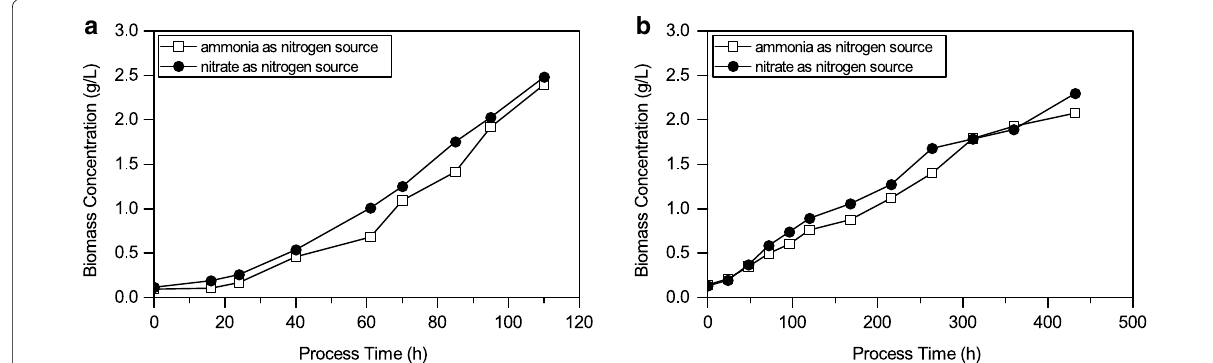
Fig. 3 Cultivation of Synechocystis sp. PCC 6714 on two different nitrogen sources, nitrate and ammonia, under continuous illumination. Given are biomass concentration over time for a photobioreactor cultivations and b shake flask experiments. The values shown are the mean of three individual experiments, a single standard deviation is given as error